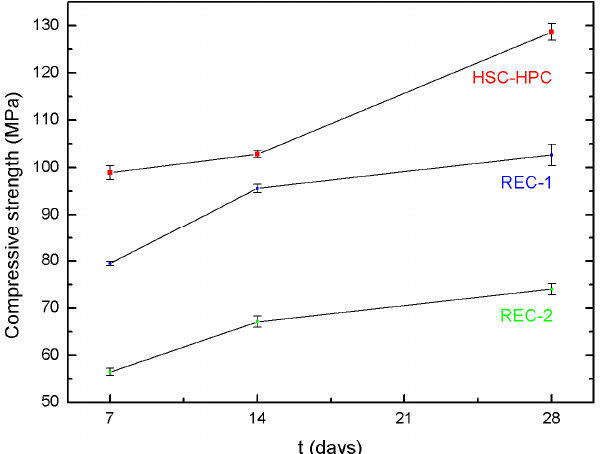
Figure 3. Strength of concretes after 7, 14, and 28 days.